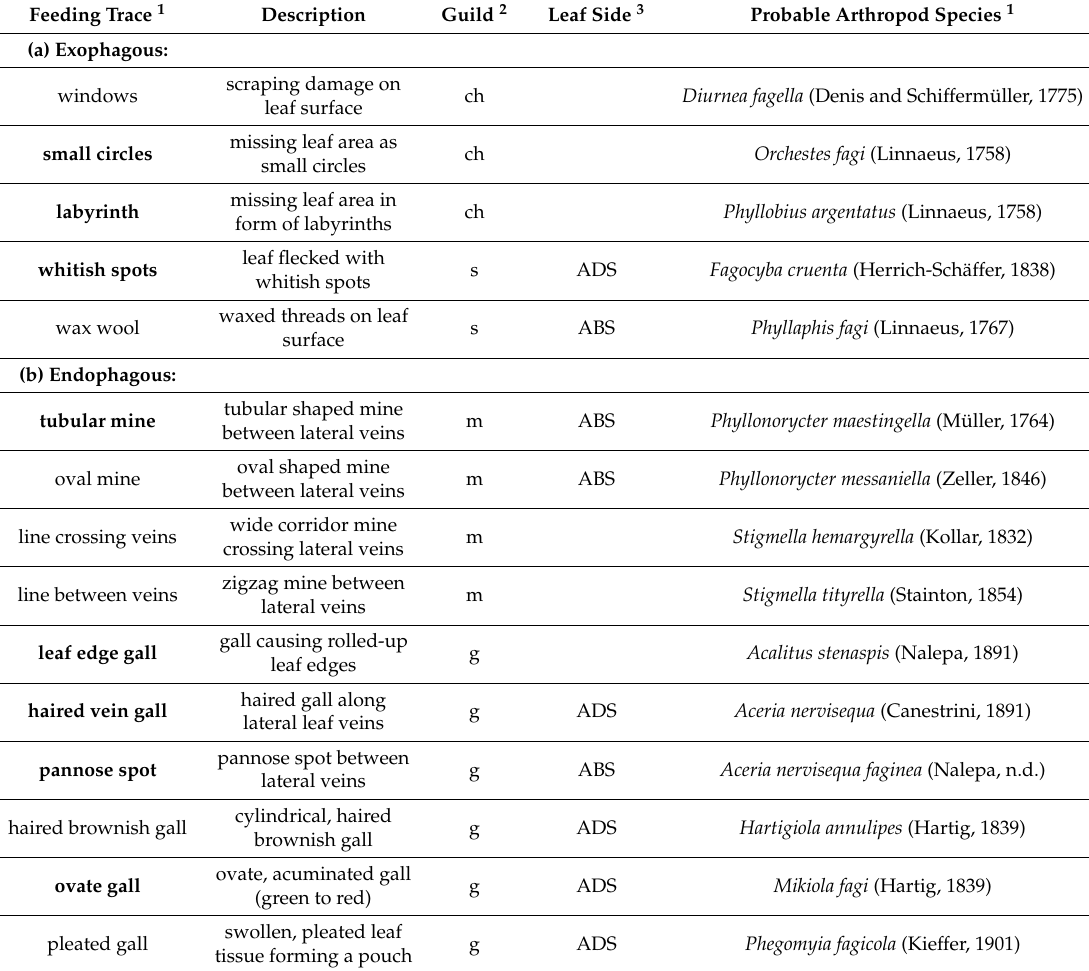
Table 1. List of 15 identified arthropod herbivore feeding traces (recognizable taxonomic unit = RTU) on leaves of Fagus sylvatica . Presented are feeding traces for (a) exophagous and (b) endophagous feeding guilds. Images of all feeding traces are available in Appendix